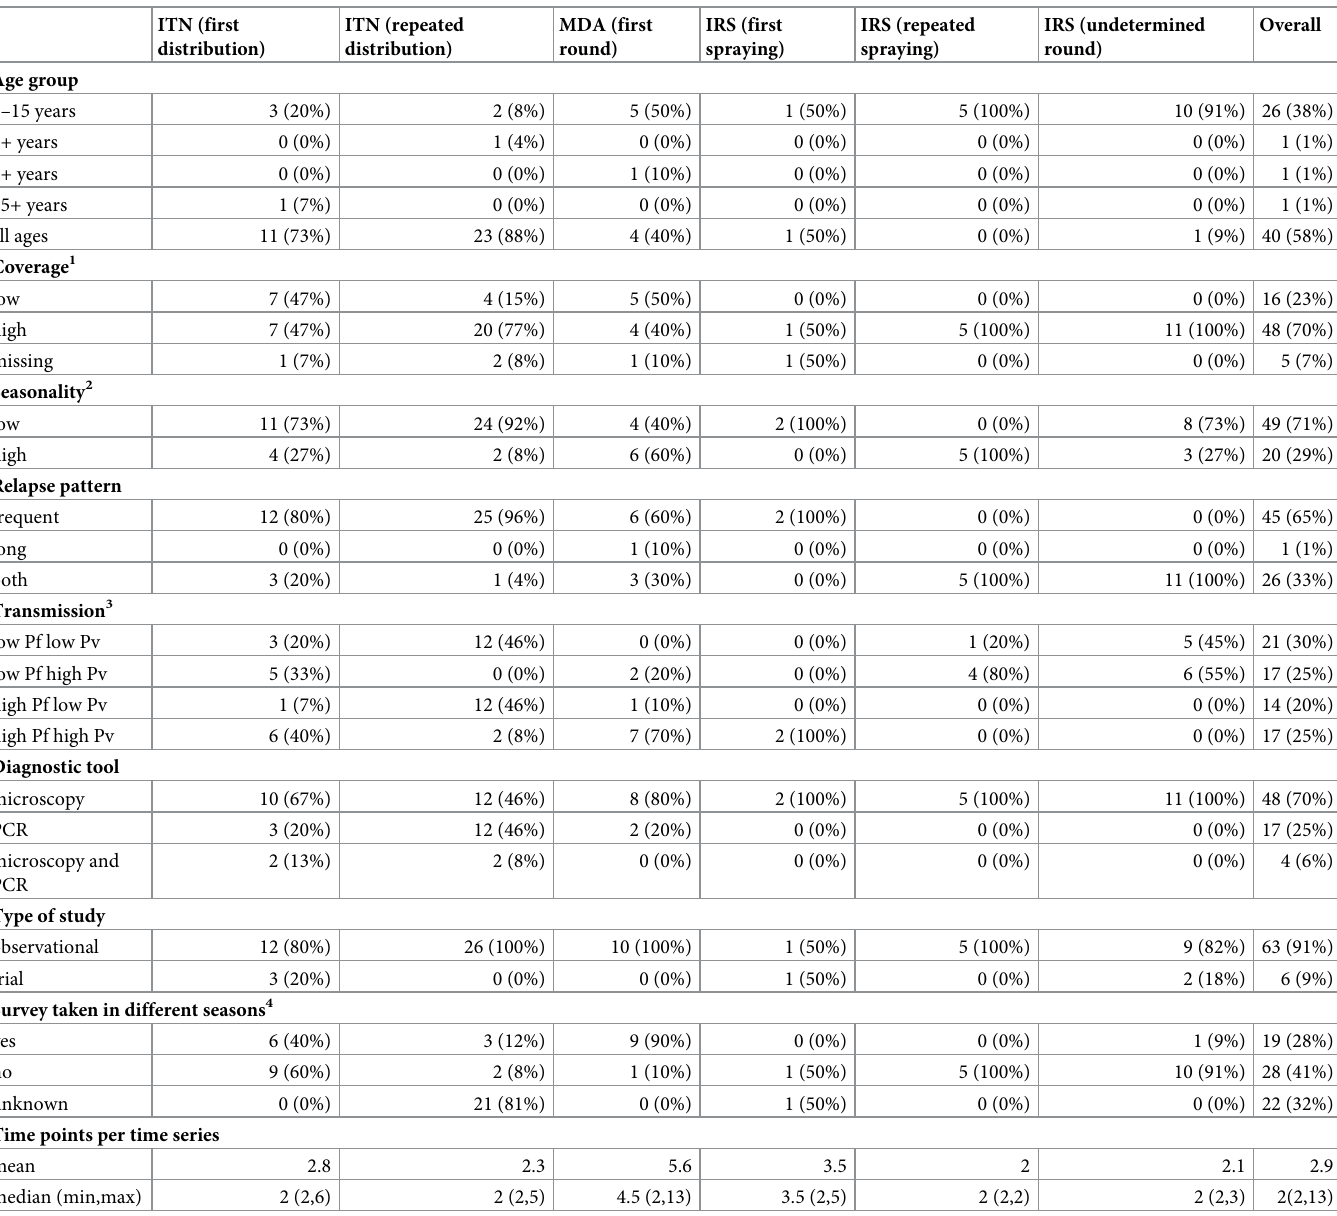
Table 3. Characteristics of the 69 series of time-points of patent infections by